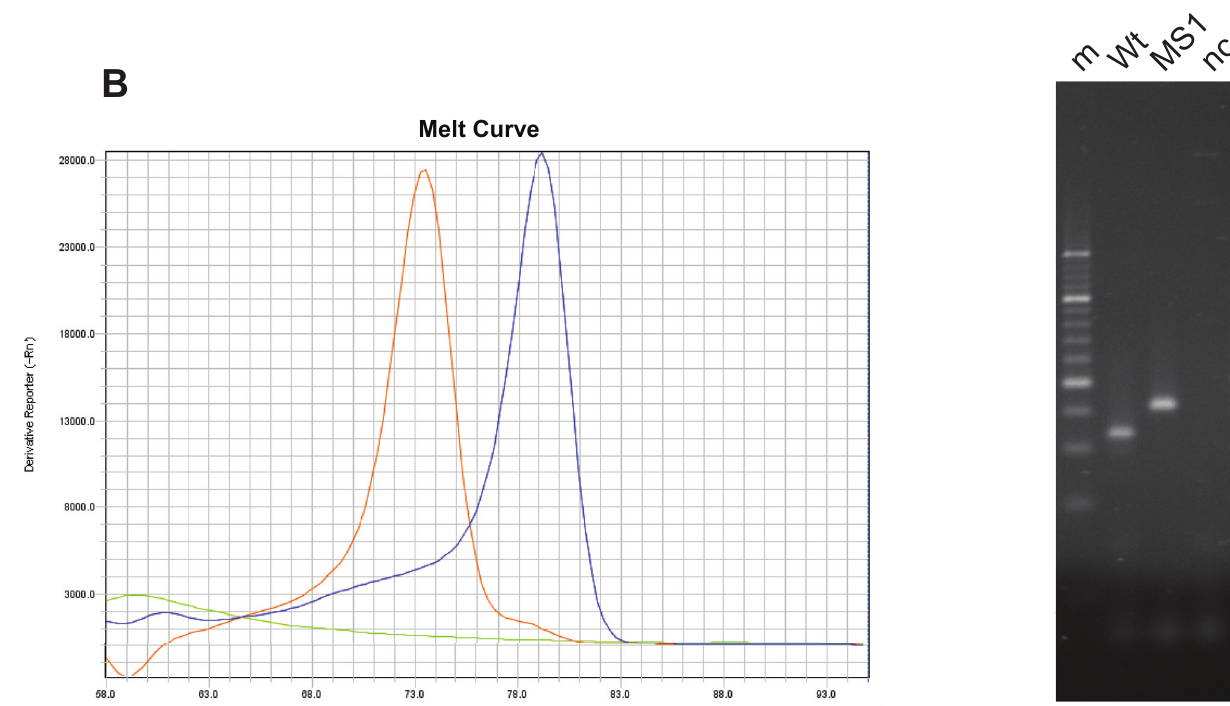
PLOS ONE | https://doi.org/10.1371/journal.pone.0175969 April 18,